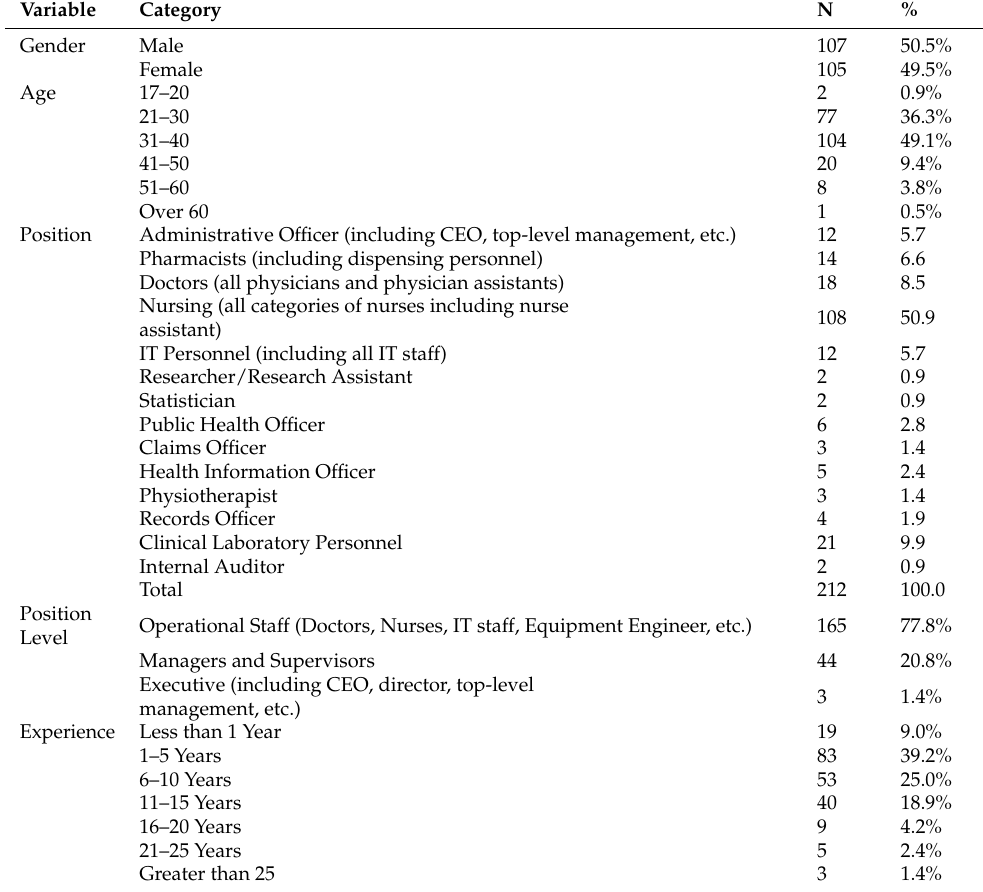
Figure 3. Role categories of respondents. Table 5. Participants’